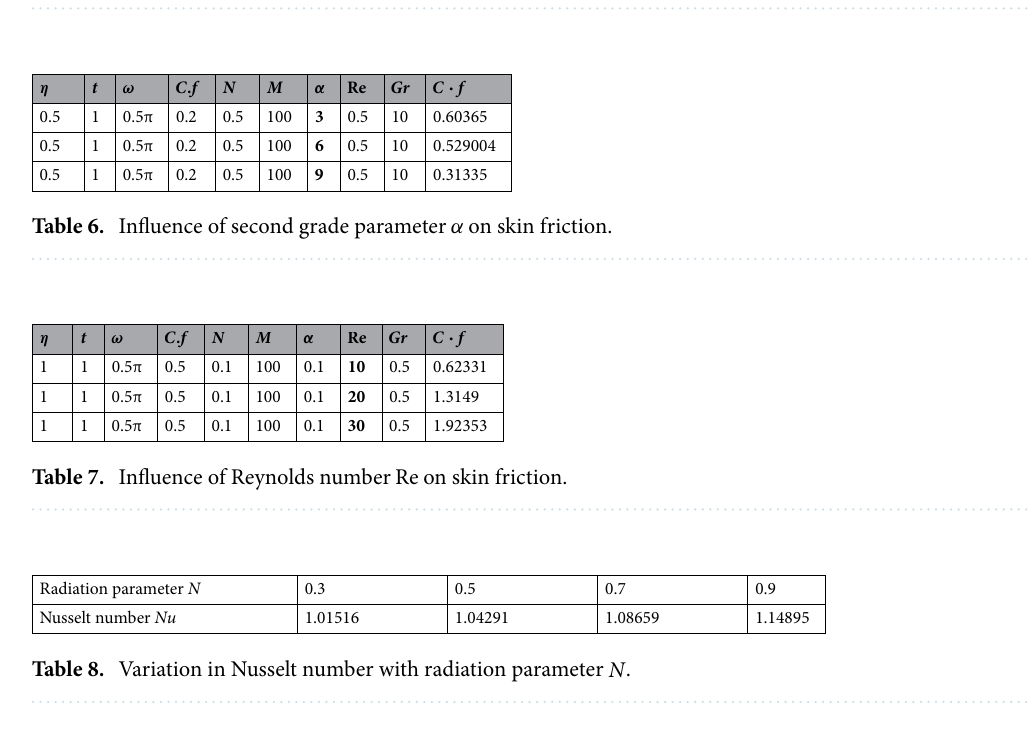
Table 5. Influence of rotational parameter η on skin friction.